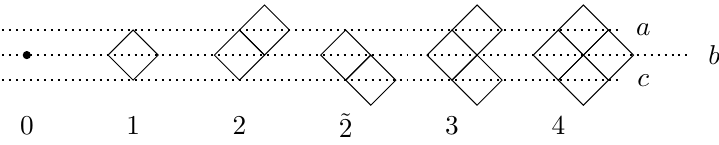
Figure 2 . The list of allowed diagrams. The diagrams are labeled by 0 , 1 , 2 , ˜2 , 3 , 4 which indicate the number of boxes. Three dotted lines correspond to the spaces a , b , c such that a box lying on one of these lines represents a basis vector of the respective